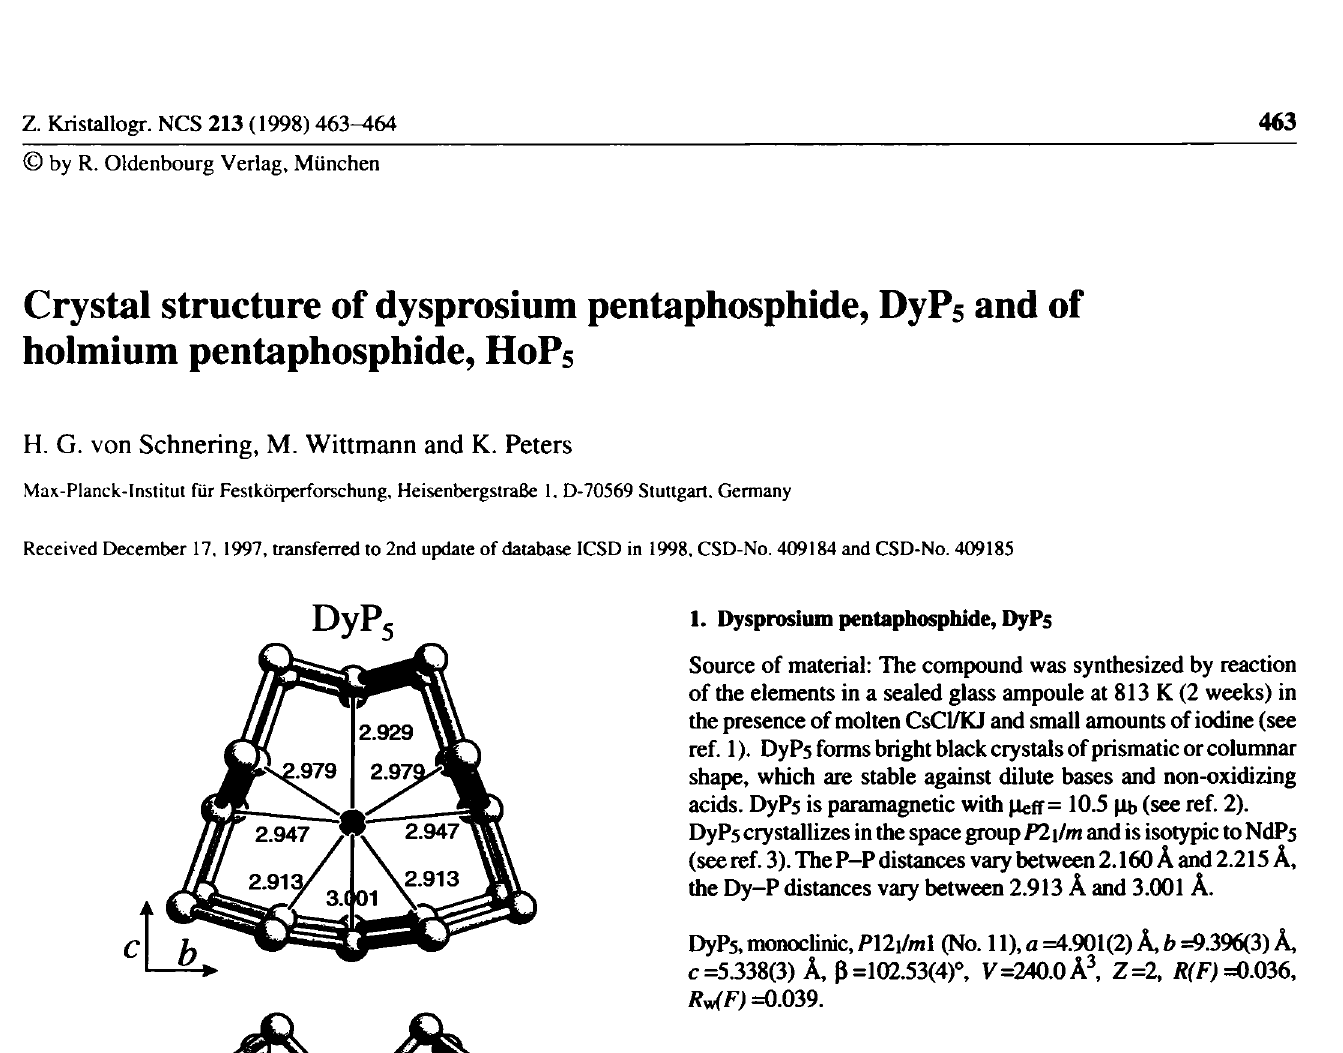
Table 1. Parameters used for the X-ray data collection Crystal: